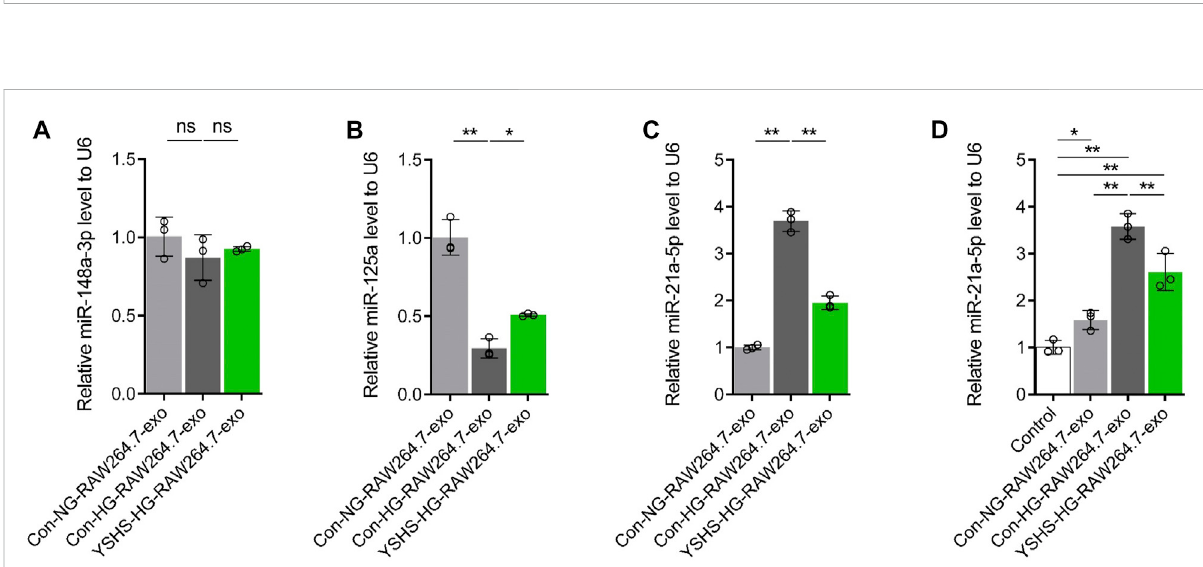
FIGURE 6 Effect of exosomes secreted by macrophages treated with high glucose and (or) YSHS-serum on the content of miR-21a-5p in podocyte MPC5 cells. (A-C) Effect of medicated serum of YSHS granule on the contents of miR-148a-3p, miR-125a, and miR-21a-5p in macrophage-derived exosomes induced by HG. (D) Measurement of the miR-21a-5p content by qRT-PCR in MPC5 cells with different treatments. Data analysis adopts a one-way analysis of variance. SD indicates error bars. * p < 0.05 and ** p <